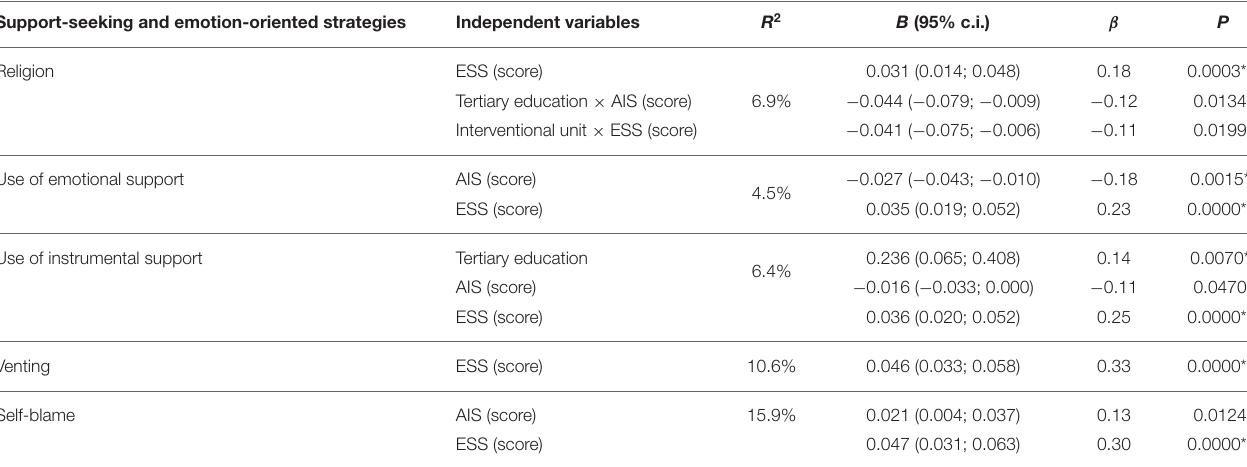
TABLE 4 | Regression models for support-seeking and emotion-oriented strategies ( N = 448). Support-seeking and emotion-oriented